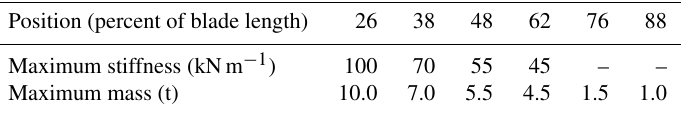
Table 1. Load positions and boundary conditions for load element.